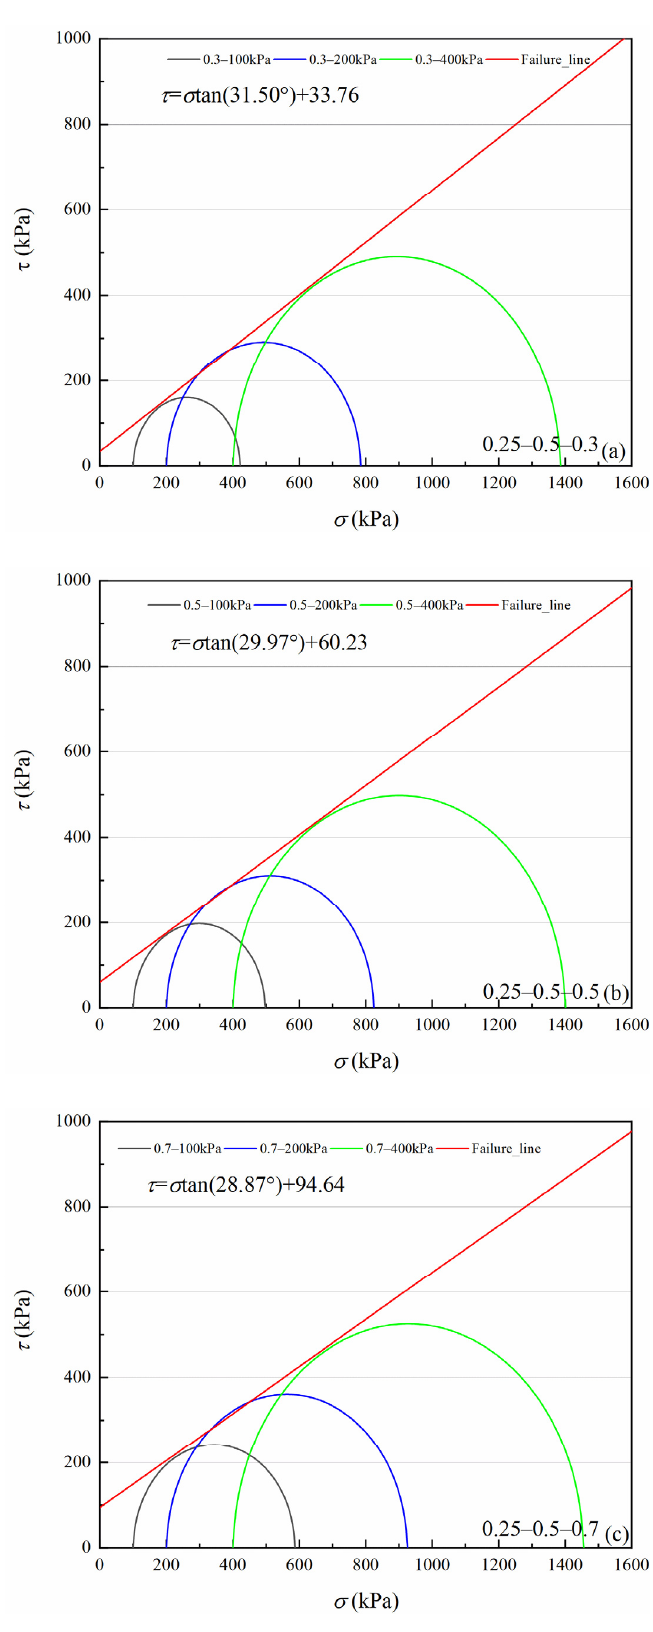
Figure 9. Shear strength envelopes of 0.25–0.5 mm particle groups volcanic soil with different relative density ( Dr ) under the peak state:( a ) Dr = 0.3, ( b ) Dr = 0.5, ( c ) Dr = 0.7.